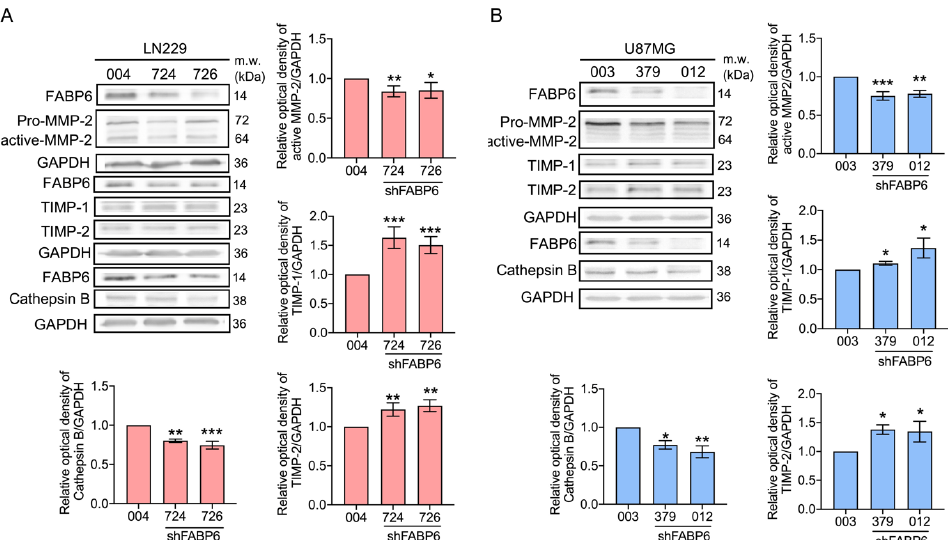
Figure 4. Effects of shFABP6 on the expression levels of the extracellular matrix (ECM) degradation-associated proteins in